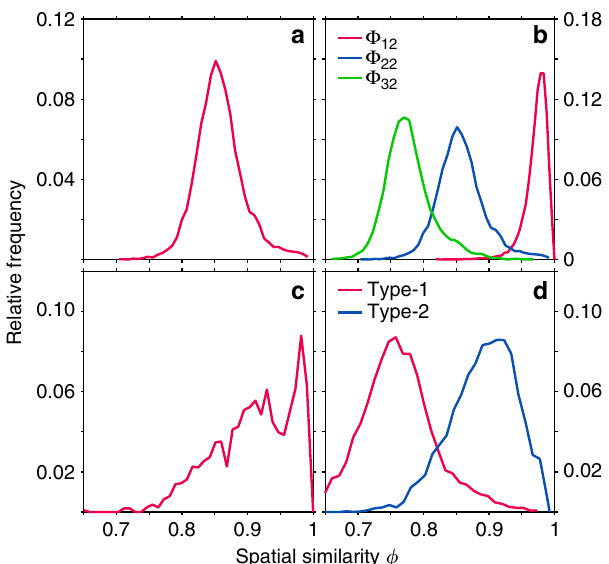
Figure 3 | Example LSU distributions. ( a ) The distribution of spatial similarity statistics for tree comparisons of depth 2 and locality 2 ( F 22 ) for an amorphous diamond network. ( b ) LSU distributions F n 2 of amorphous diamond for different tree depths n . ( c ) F 22 for a 216-vertex sample comprising a single gyroid crystallite suspended in amorphous gyroid, demonstrating LSU’s ability to differentiate between phases. ( d ) F 22 distributions for two characteristic types of amorphous gyroid network— type-1 (1-tree local order) and type-2 (2-tree local